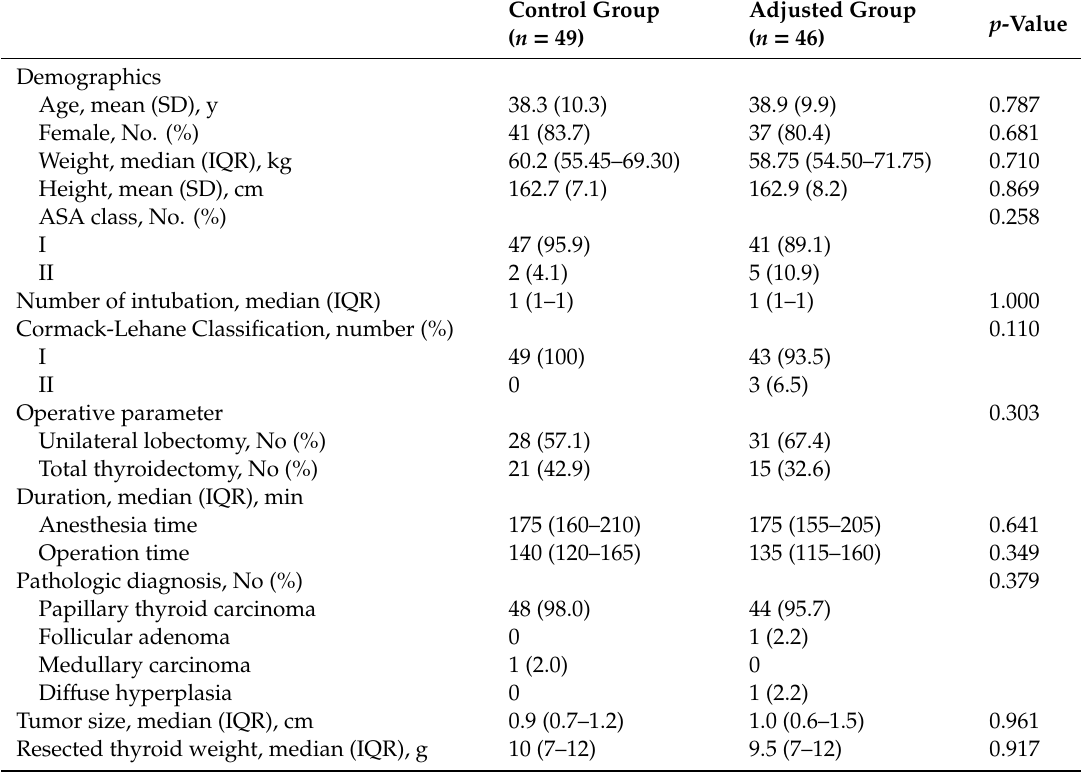
Table 1. Patients and surgery